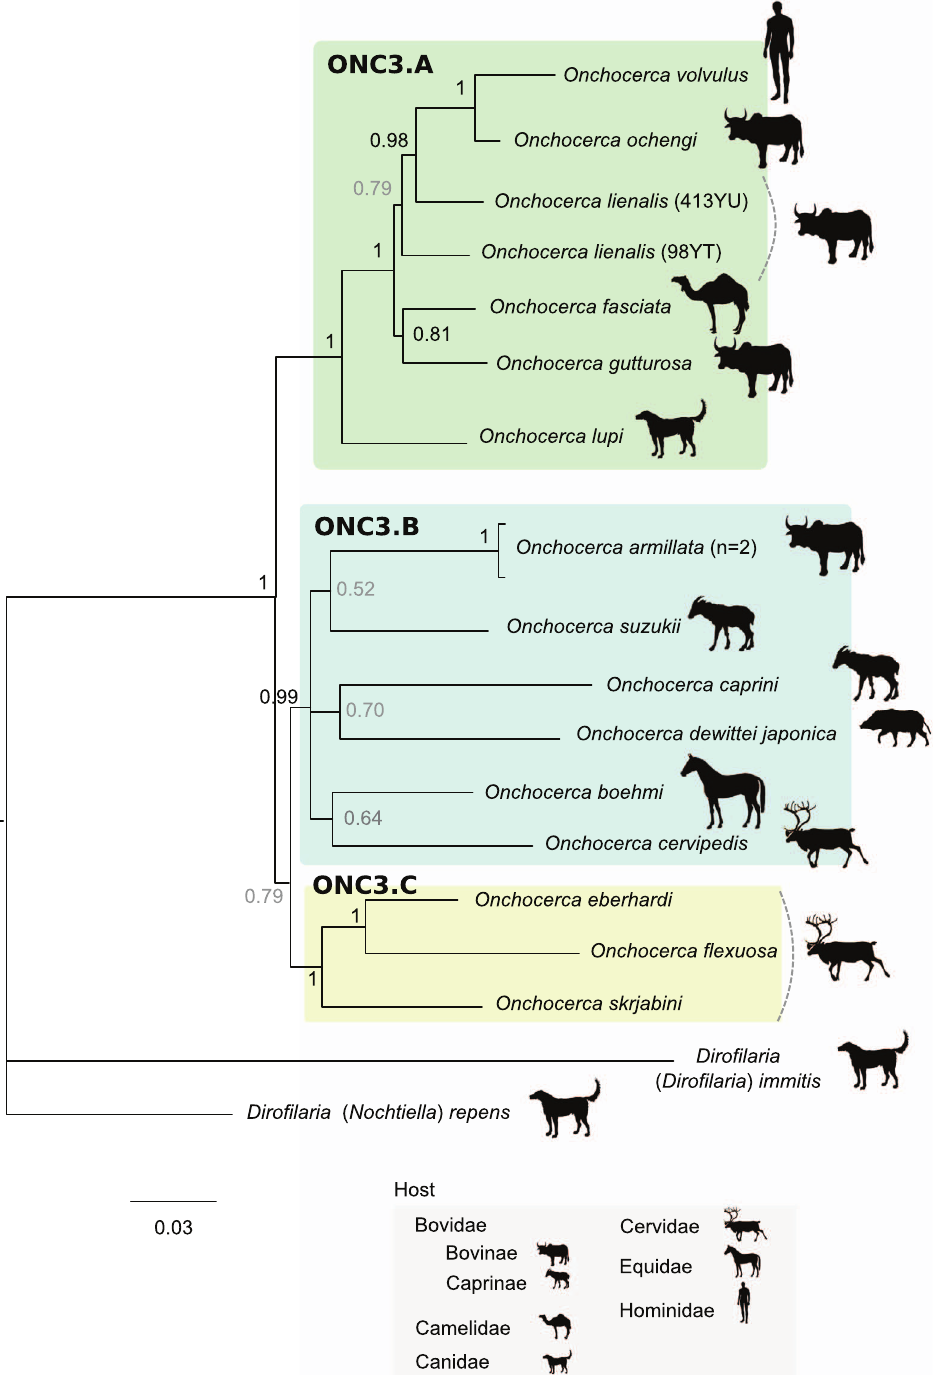
Figure 4. Phylogeny of the Onchocerca genus based on partitioned concatenated datasets of seven markers. Analysis is based on 12S rDNA, cytochrome oxidase subunit I ( cox 1), RNA polymerase II large subunit ( rbp1 ), heat shock protein ( hsp70 ), myosin heavy chain ( myoHC ), 18S rDNA and 28S rDNA sequences. Dirofilaria immitis and Dirofilaria repens were used as outgroups. The topology was inferred using Bayesian inference. Nodes are associated with Bayesian posterior probabilities based on one run of five million generations. The scale bar indicates the number of nucleotide substitutions. The host vertebrate family (or subfamily) for each filarial species is indicated using the specified